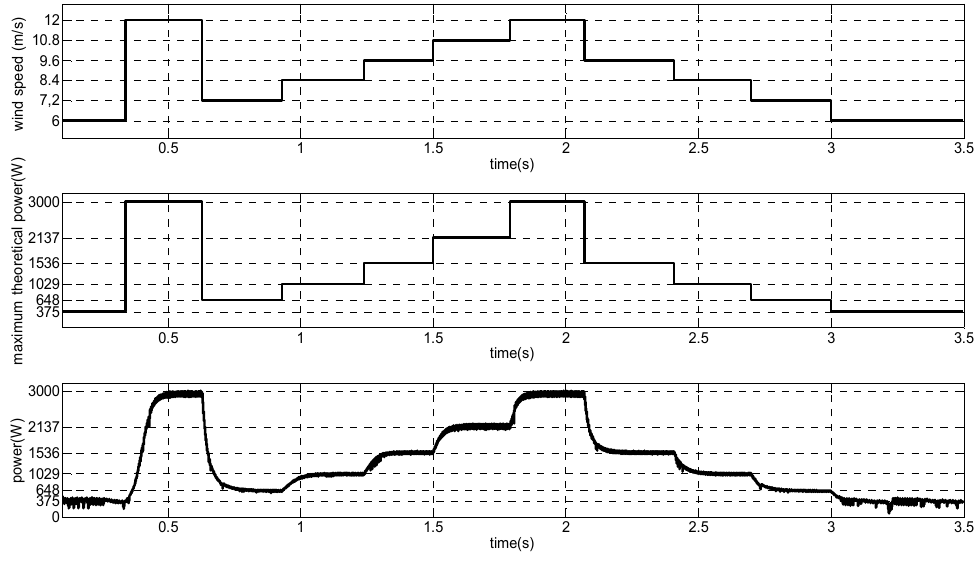
Figure 22. Wind speed with step variation, theoretical MPP and output